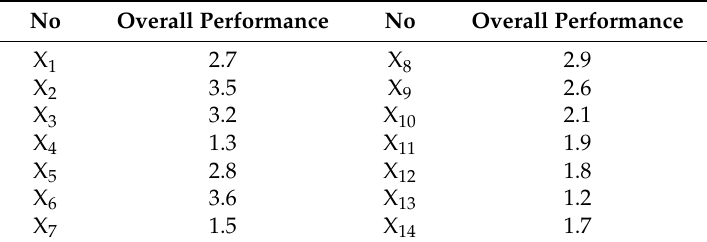
Table 2. The value of MI between the design variables and the overall